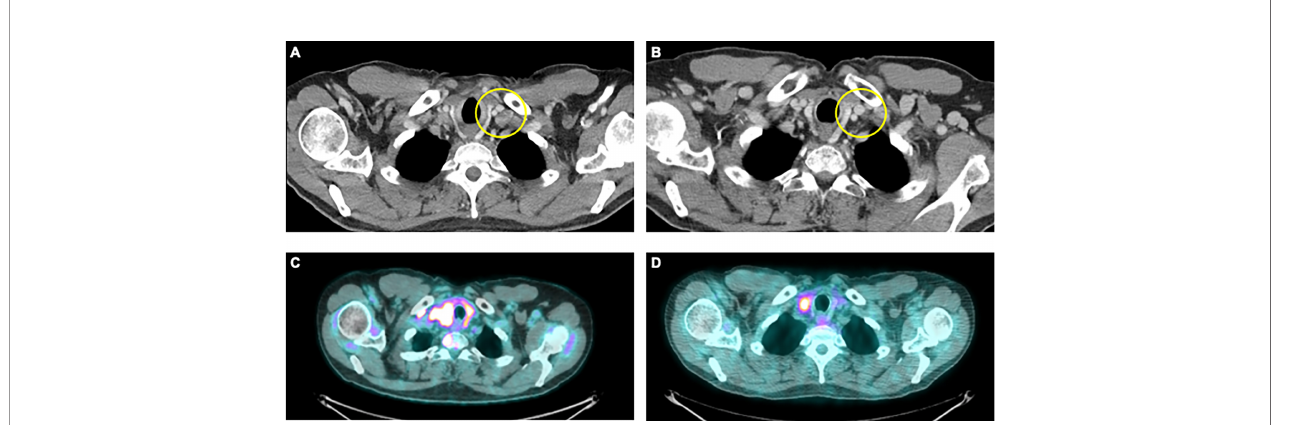
FIGURE 1 | Representative images from patients in this case series. (A) CT imaging from a 58-year-old male former smoker with a diagnosis of stage IVB NSCLC with an adenosquamous histology harboring a CD74-ROS1 fusion upon progression on entrectinib and prior to use of carboplatin, pemetrexed and pembrolizumab. (B) CT imaging of best-treatment response with signi fi cant reduction in the size of the left supraclavicular lymph node. (C) PET/CT imaging from a 40-year-old male never smoker with stage IVB NSCLC with an adenosquamous histology harboring an EML4-ALK fusion prior to treatment with single agent pemetrexed. (D) PET/CT imaging demonstrating signi fi cant improvement within known right paratracheal